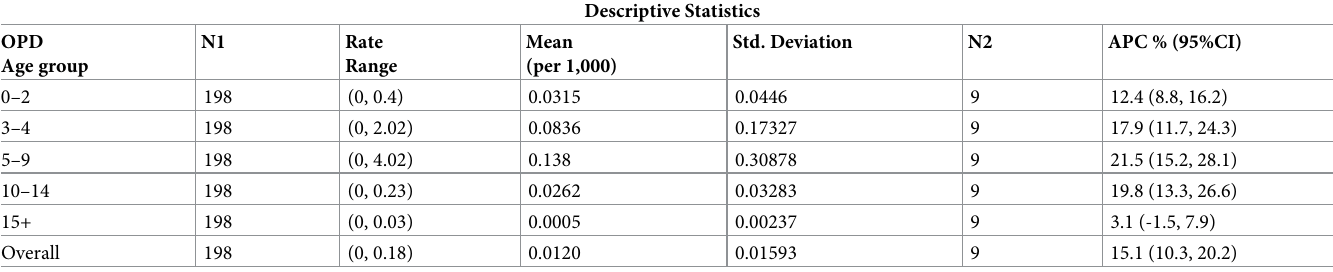
Table 1. Descriptive statistics on annual rate of scarlet fever in outpatient setting from 2009 to 2017 and annual percentage change (APC).